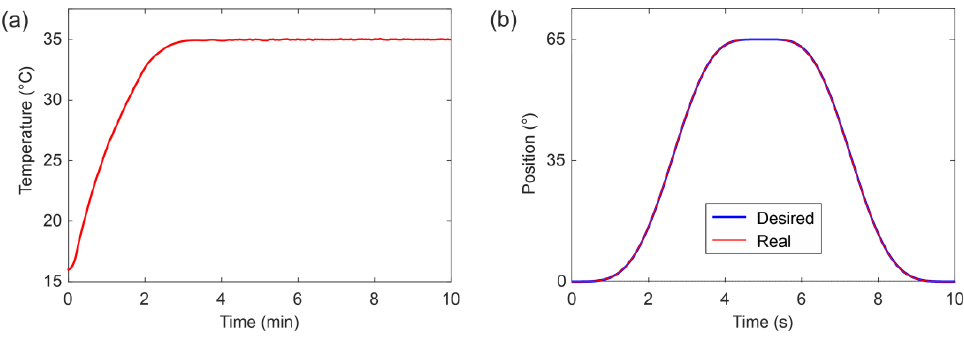
Figure 16. Experimental results of the robot performing dorsiflexion and plantarflexion. ( a ) temperature sensor output, ( b ) PID controller tracking performance.